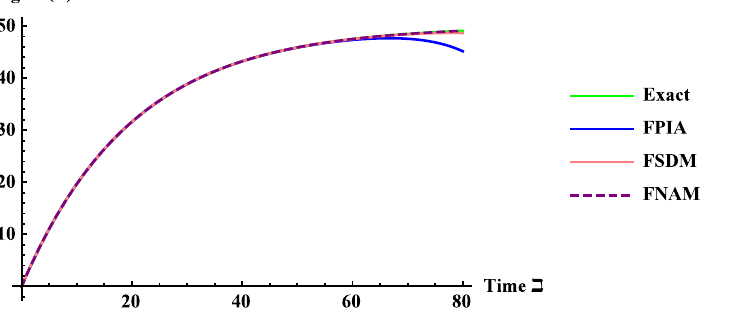
Figure 4. Graphical comparisons of classical solution and approximate solutions of resistor–capacitor circuit at α = 1, R = 4, C = 5, E 0 = 10 and v 0 = 0.